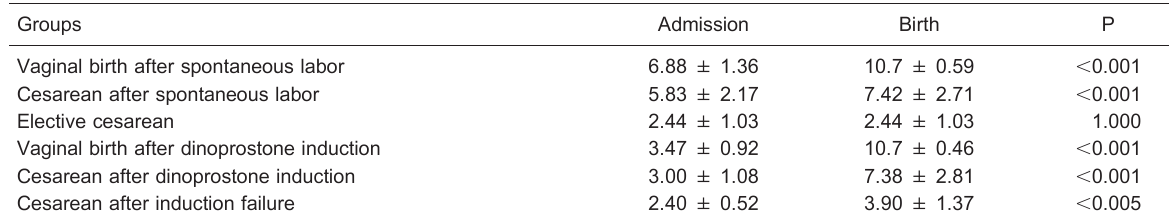
Table 2. Bishop scores at admission and immediately before birth of patients with and without dinoprostone treatment. Groups